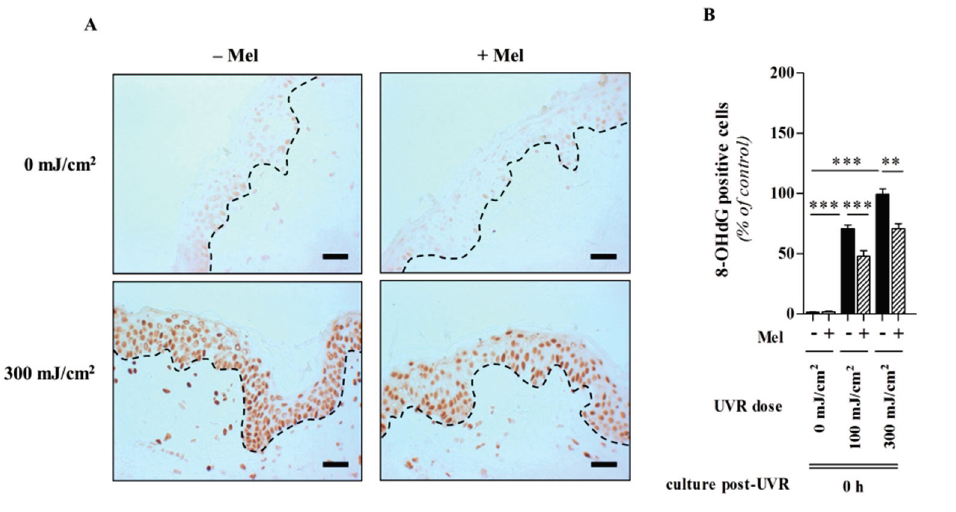
Figure 9. Melatonin significantly decreases the dynamics of formation of UVR-induced oxidative DNA damage, namely 8-hydroxy-2'-deoxyguanosine in human skin. Sections were labeled using immunohistochemical staining ( A ) for 8-OHdG and were detected by catalyzed signal amplification using 3,3'-diaminobenzidine (yields brown-colored precipitate). One representative experiment of three is shown. Dashed line shows the basement membrane. Bars = 50 μ m (magnification, 200×); Evaluated data ( B ) were presented as pooled means ± SEM of three independent experiments containing six taken images per condition. Statistically significant differences were indicated as ** p < 0.01; *** p < 0.001; n.s., not significant, using the ANOVA with appropriate post hoc